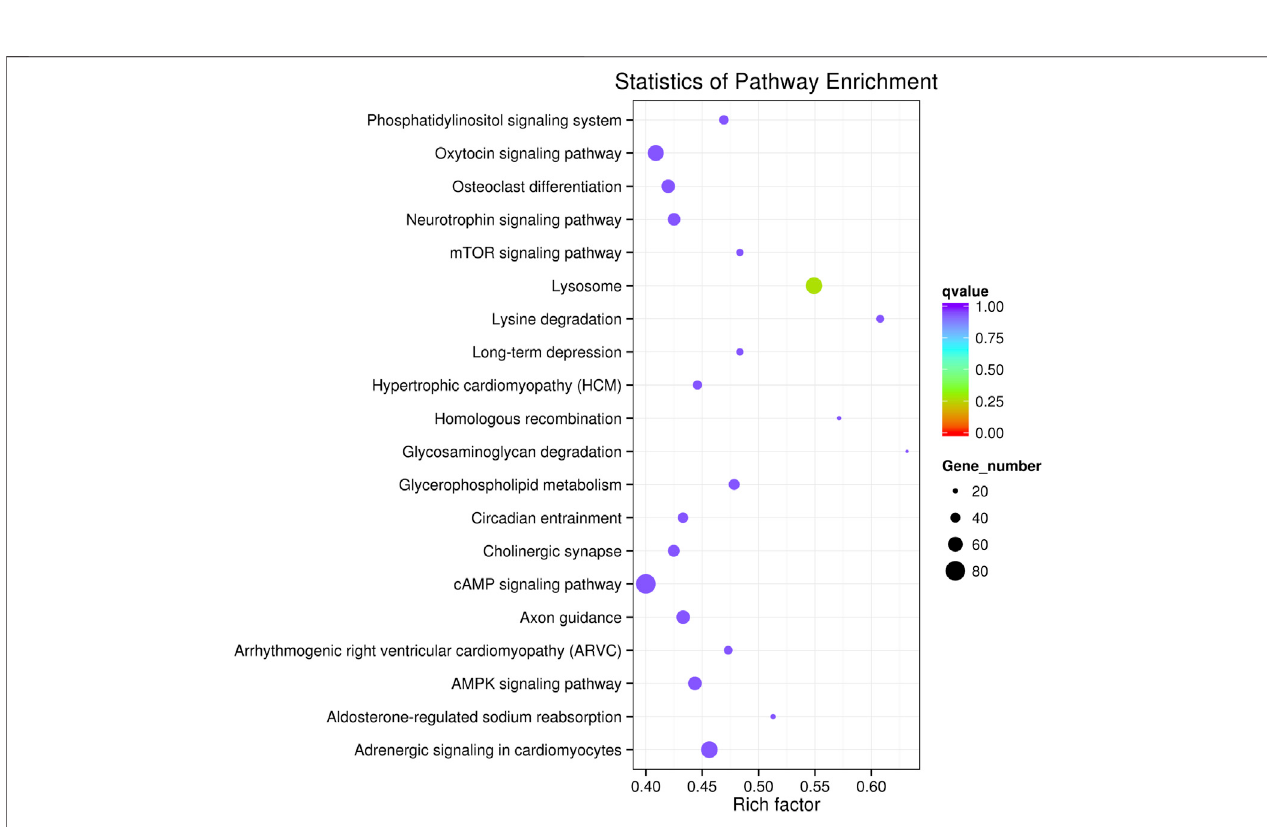
FIGURE 6 | KEGG pathway analysis of the target genes of known differentially expressed miRNAs in K562 cells after CAP treatment. Horizontal axis: rich factor. The larger the point, the higher the enrichment degree, the more candidate target genes in this pathway, and the color of the point corresponds to a different q value range. Vertical axis: the de fi nition of the